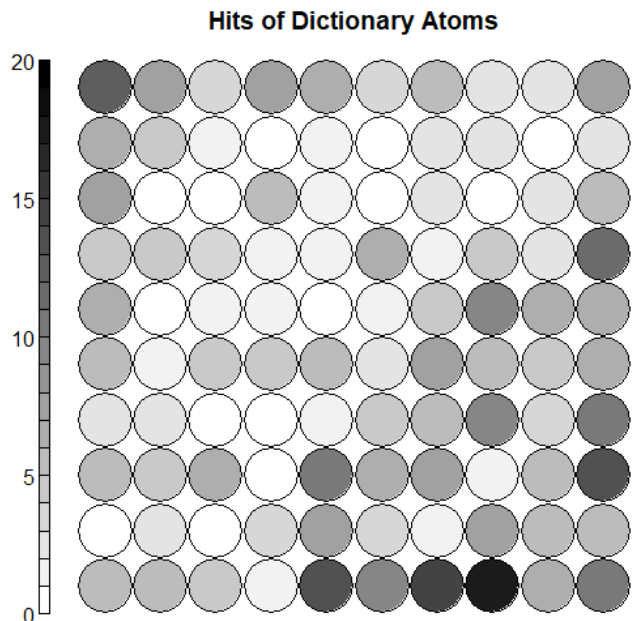
Figure 8. Hits of Dictionary Atoms for SOM neurons.